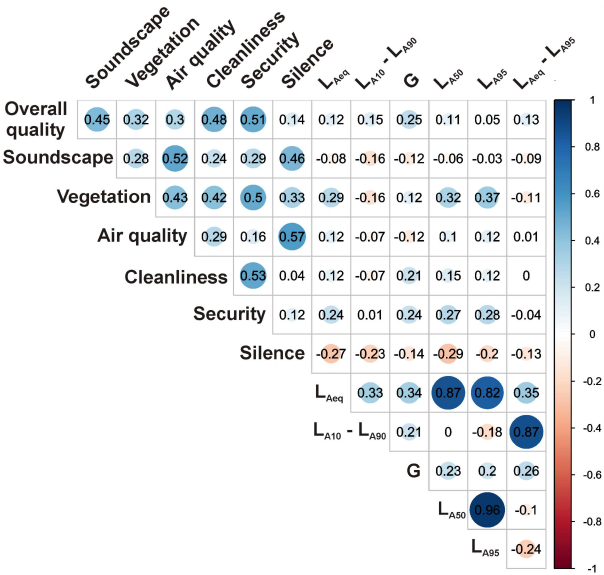
Figure 7: Pearson’s correlation matrix among subjective ratings of park’s features and acoustic